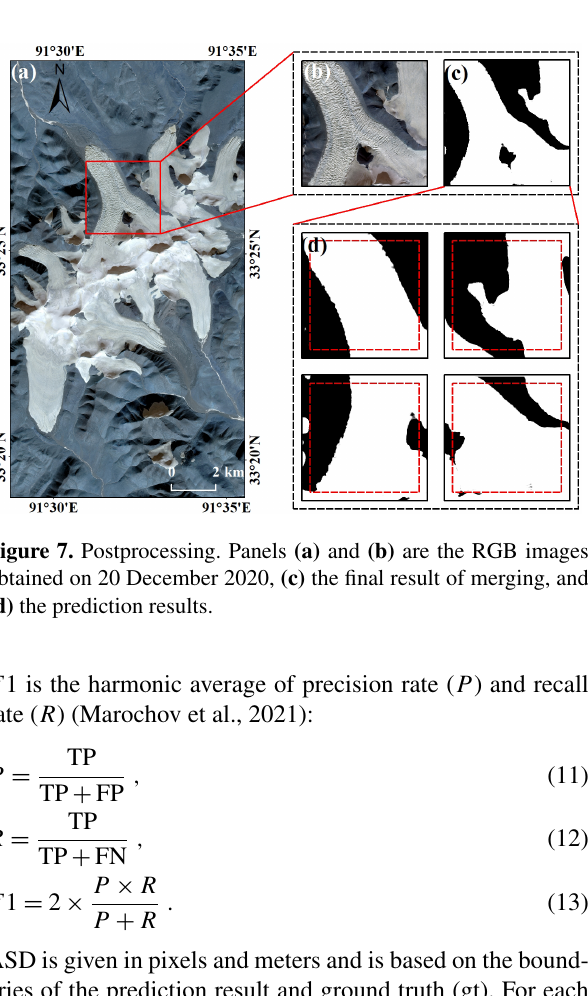
Figure 6. The RGB Gaofen-6 samples and ground truth are displayed in the first and second rows, respectively.